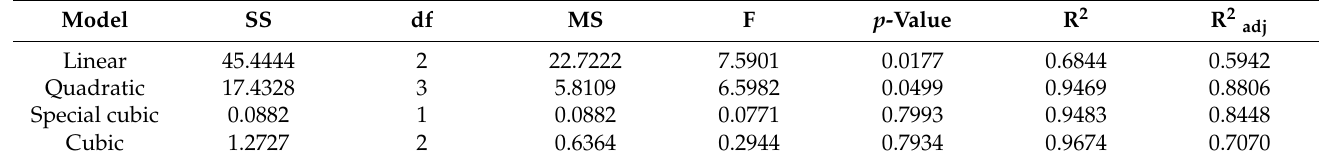
Table 4. ANOVA results for different statistical models for L. monocytogenes PCM 2191.